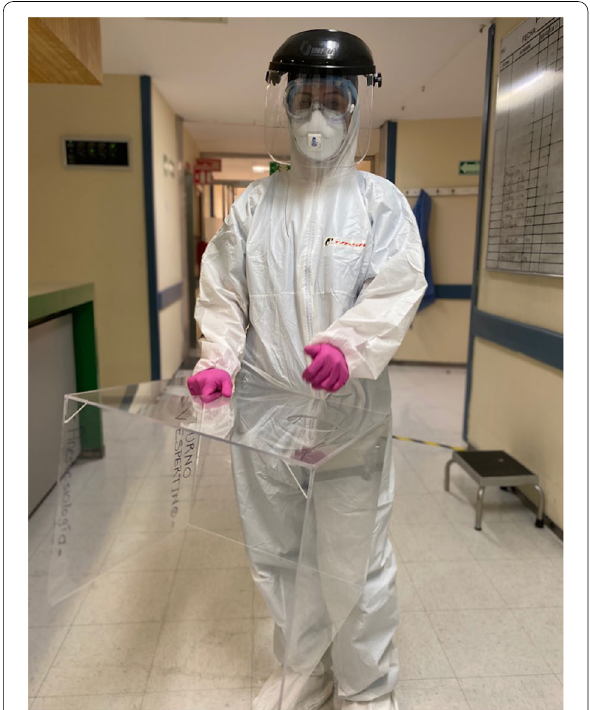
Fig. 1 Anesthesiology with personal protective equipment and aerosol‑box prior to intubation of a COVID‑19 patient